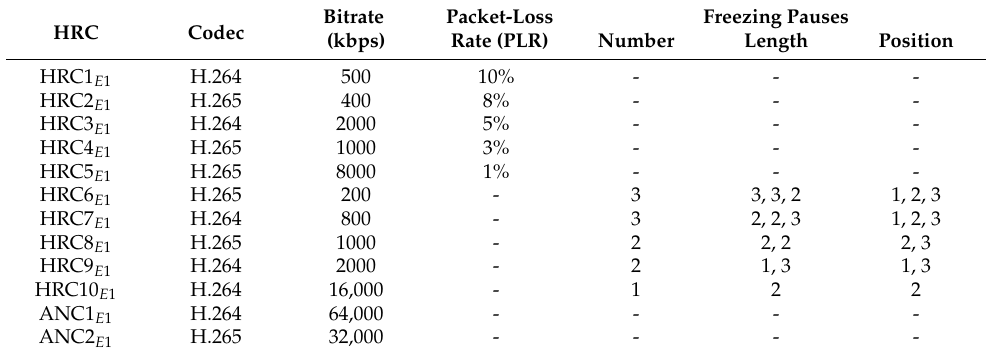
Table 7. HRC and ANC corresponding parameters used in Experiment